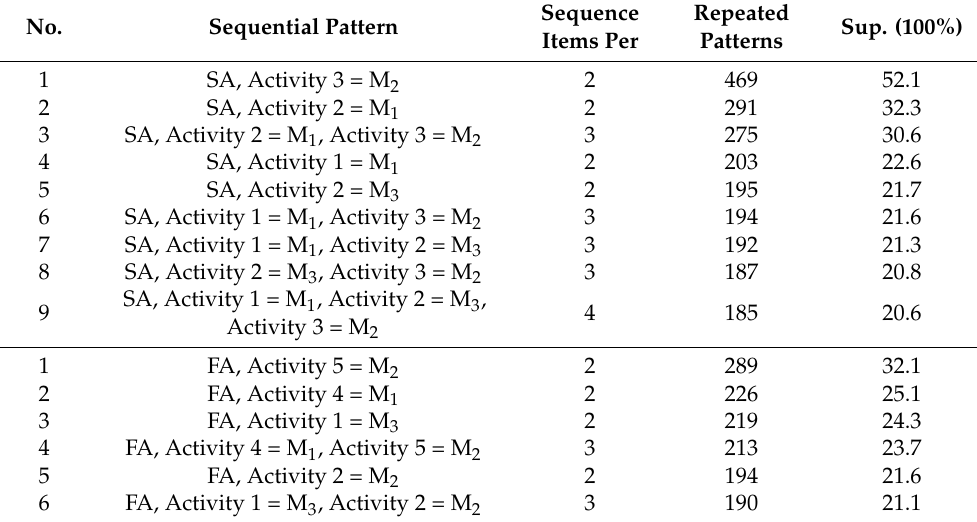
Table 12. Frequent sequential patterns for machine